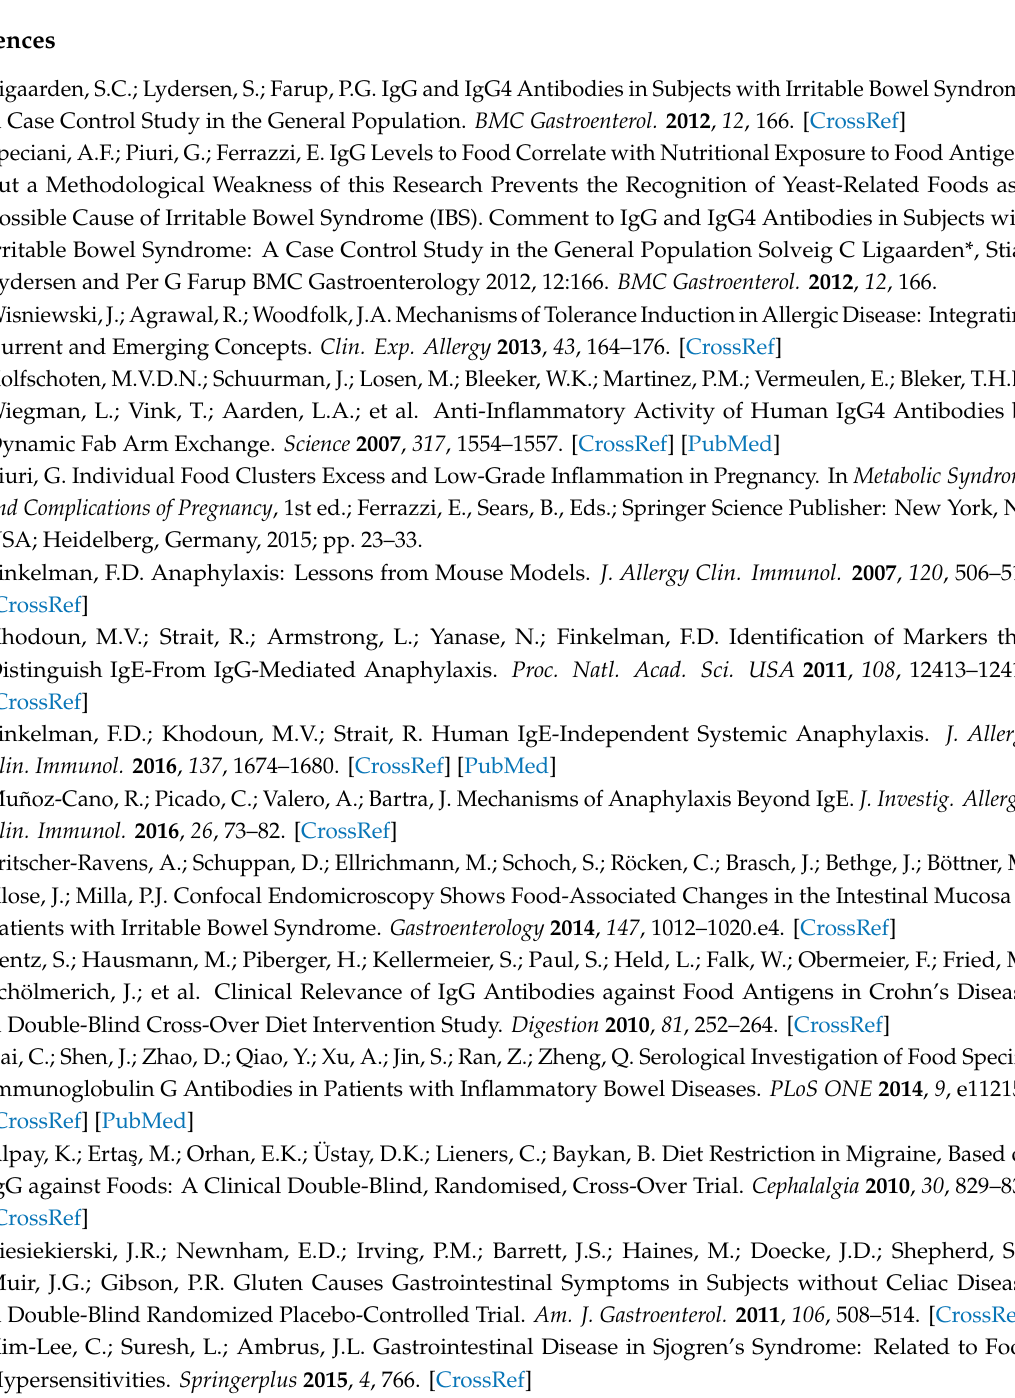
Figure S1: Graphs showing the frequency distribution of food-specific IgG concentration for each of the 44 food antigens